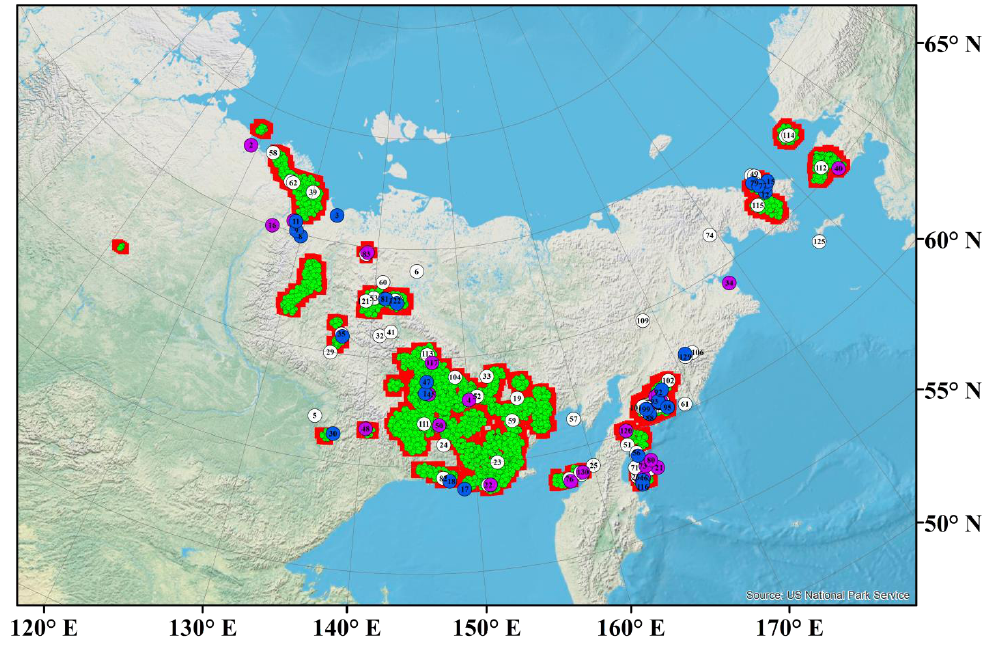
Figure 7. FCAZ zones prone to earthquakes (calculated at M R = 0.5) in the eastern sector of the Russian Arctic and earthquake epicenters with M ≥ 5.0. Designations as in Figure 3.